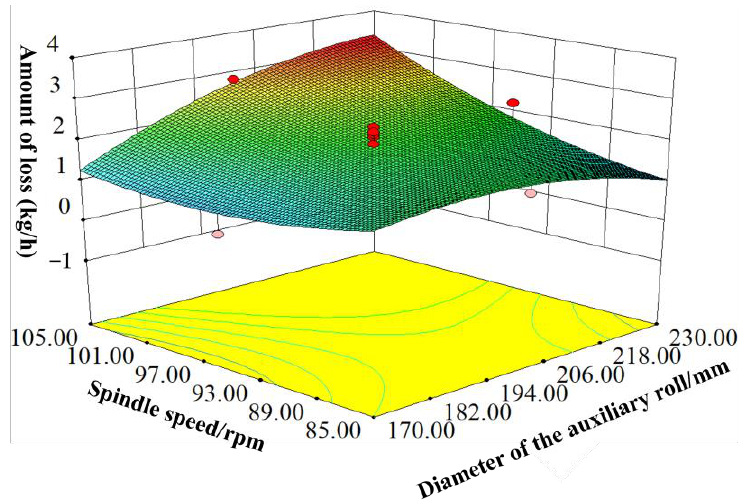
Figure 14. Influence of spindle speed and auxiliary roller diameter on the amount of loss.